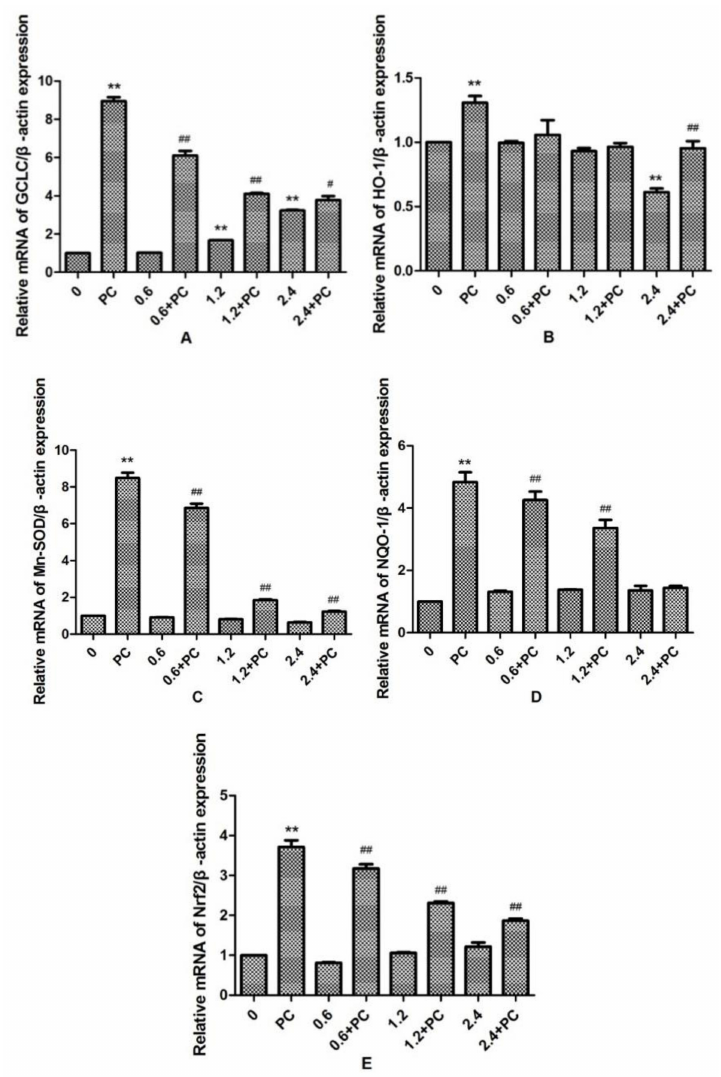
Figure 6. The effect of simultaneous treatment with BHBA and PCs on the mRNA expression of genes related to the Nrf2 signaling pathway in BEND cells. ** p < 0.01 vs. control group. # p < 0.05 vs. BHBA -treated group, ## p < 0.01 vs. BHBA -treated